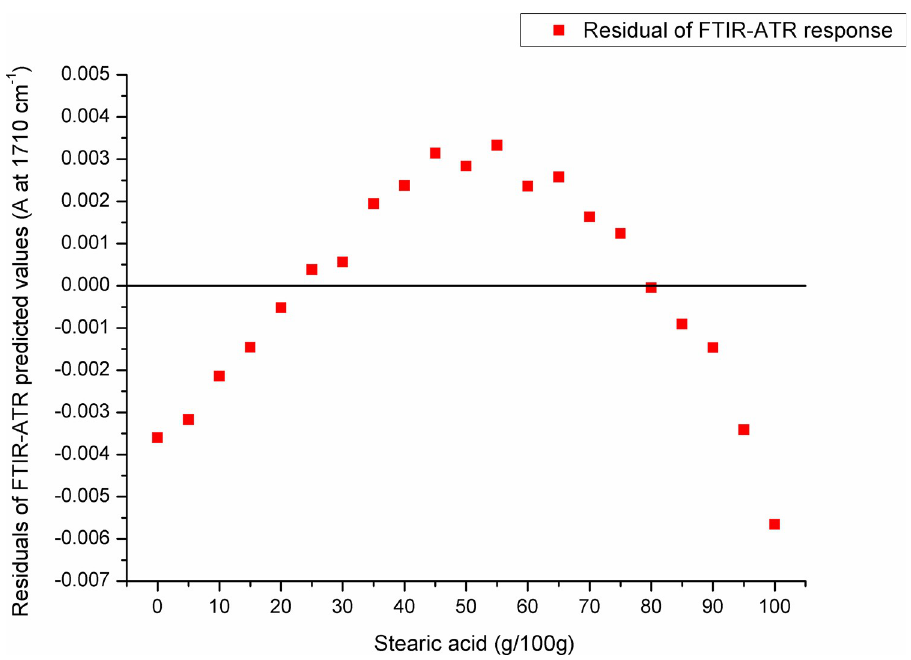
Fig 10. Residuals of FTIR-ATR prediction in the spectral region with an absorption maximum at 1710 cm -1 .